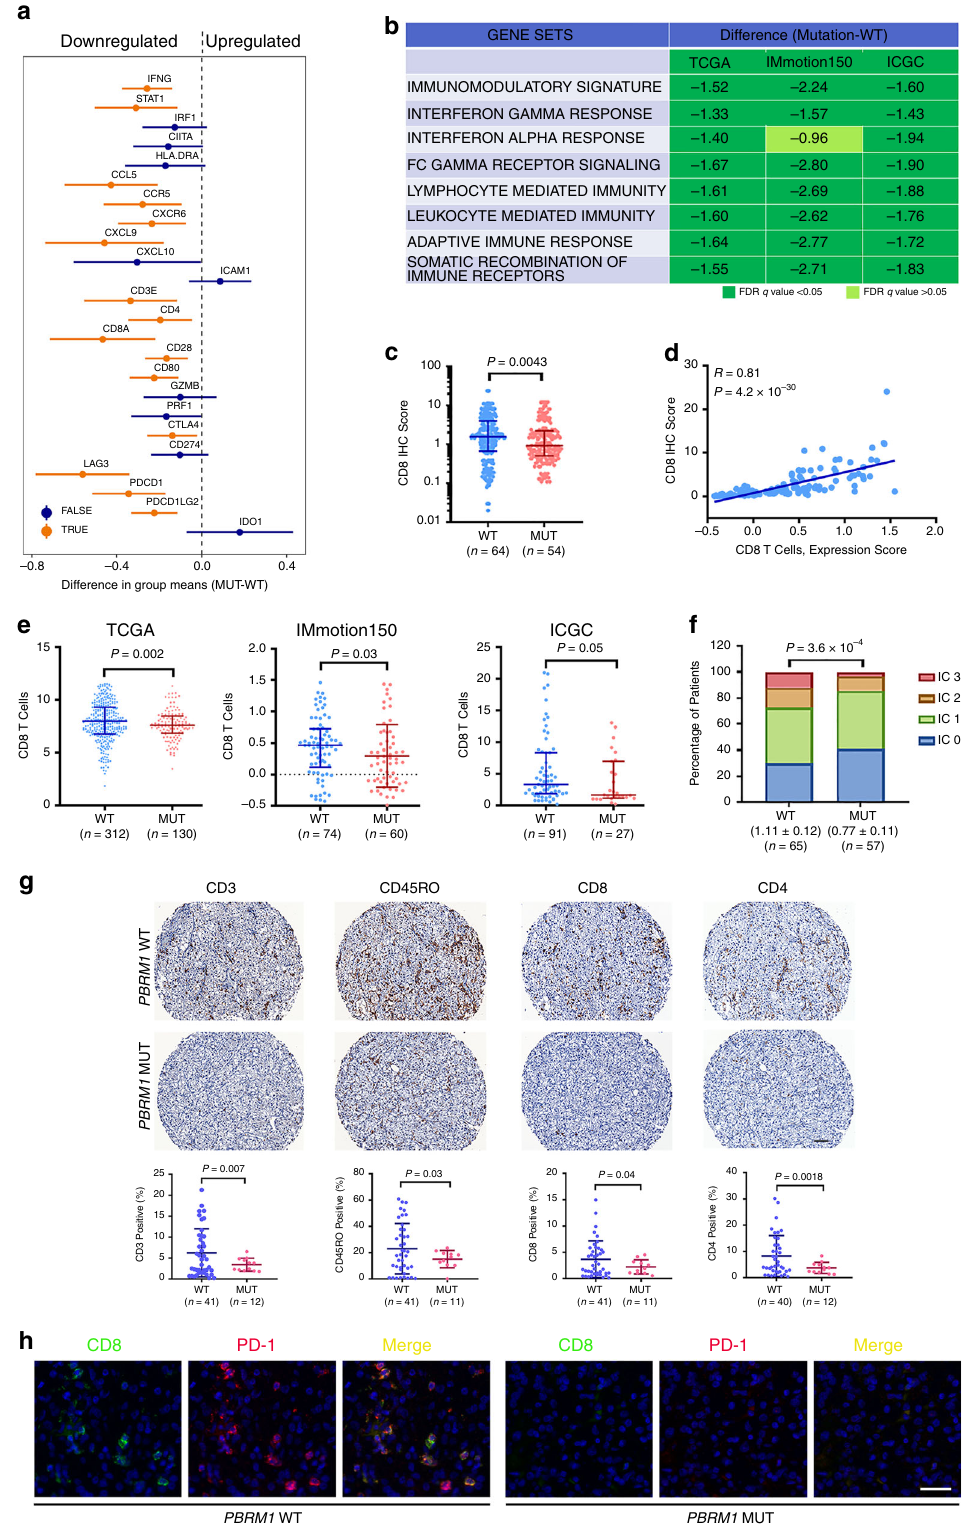
(Fig. 6a, Schema). In untreated cohorts, Renca control knockout tumors grew quickly and all mice were sacri fi ced within 20 days after tumor inoculation due to tumor growth; however, Pbrm1 knockout tumors grew signi fi cantly slower and survived